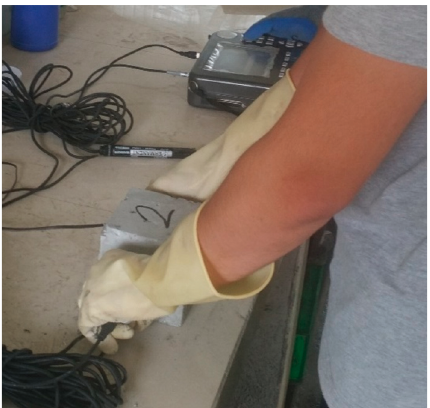
Figure 3: UPV test on 100mm